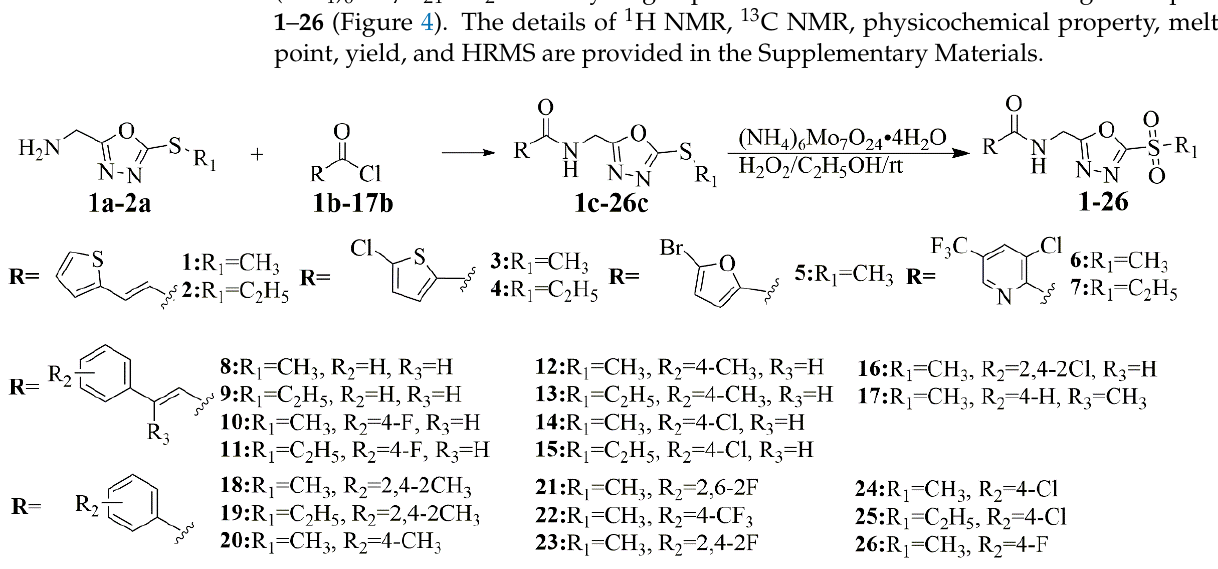
Figure 4. Synthesis route of compounds 1 − 26 .